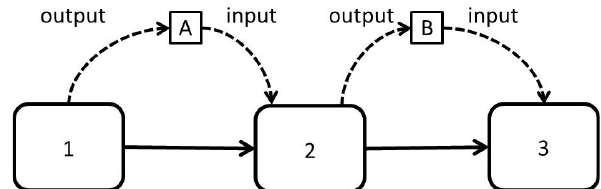
Figure 8: Input and output data should be defined in the same level as steps, so data is accessible to all steps.